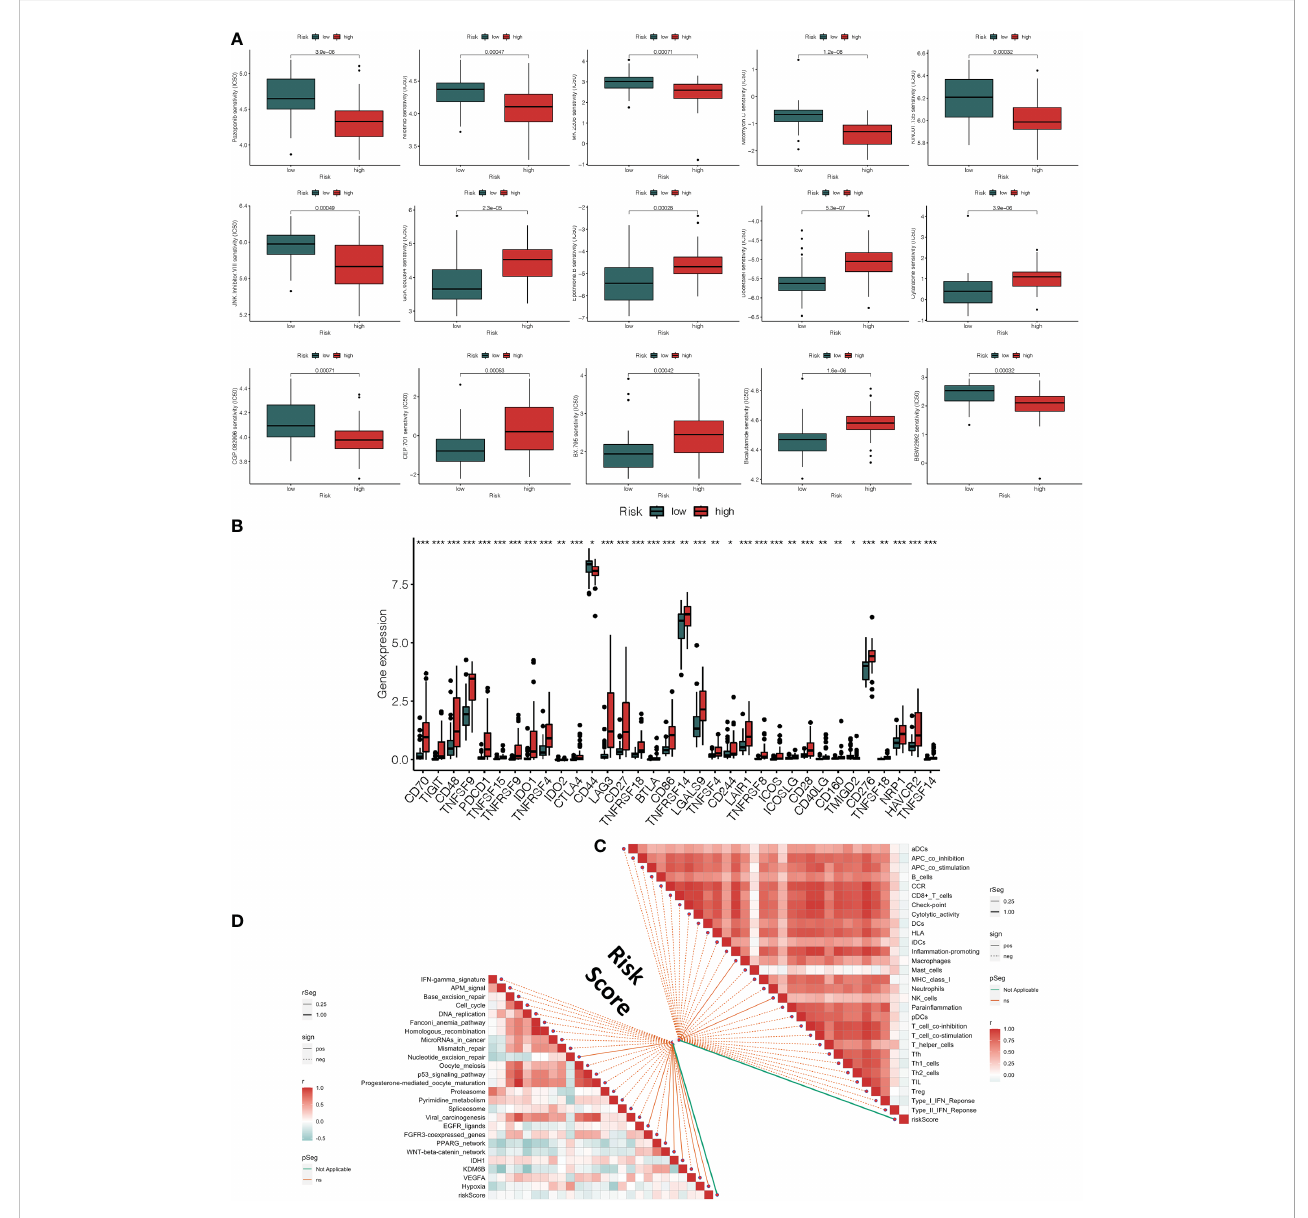
FIGURE 5 Clinical response to anti-tumor treatment and immune checkpoint-related gene expression in high and low-risk groups. (A) The prediction of chemotherapy and molecular medicines based on the risk groups (B) The difference in immune checkpoint expression in high-risk and low-risk groups. (C) Correlations between risk score and immune in fi ltrating cells. (D) Correlations between risk score and immunotherapy-predicted pathway enrichment scores. * p < 0.05, ** p < 0.01, *** p <